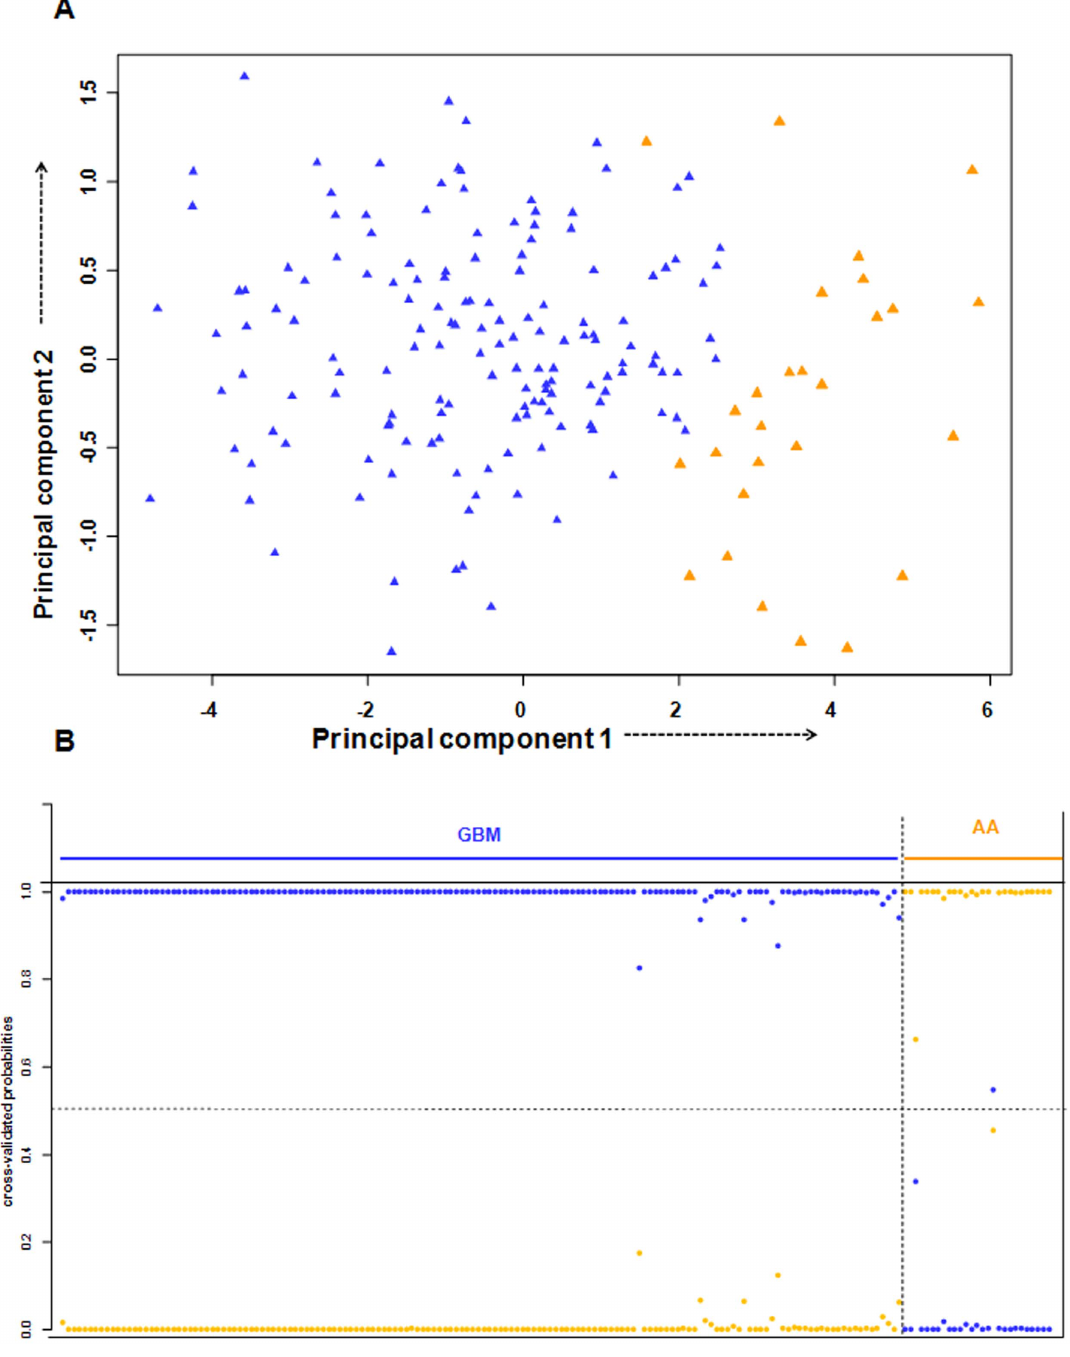
PAM identified genes between AA (n=20) and GBM (n=54) samples in test set. A scatter plot is generated using the first two principal components for each sample. The color of the samples is as indicated. B. The detailed probabilities of 10-fold cross-validation for the samples of test set based on the expression values of 16 genes are shown. For each sample, its probability as AA (orange color) and GBM (blue color) are shown and it was predicted by the PAM program as either AA or GBM based on which grade’s probability is higher. The original histological grade of the samples is shown on the top.